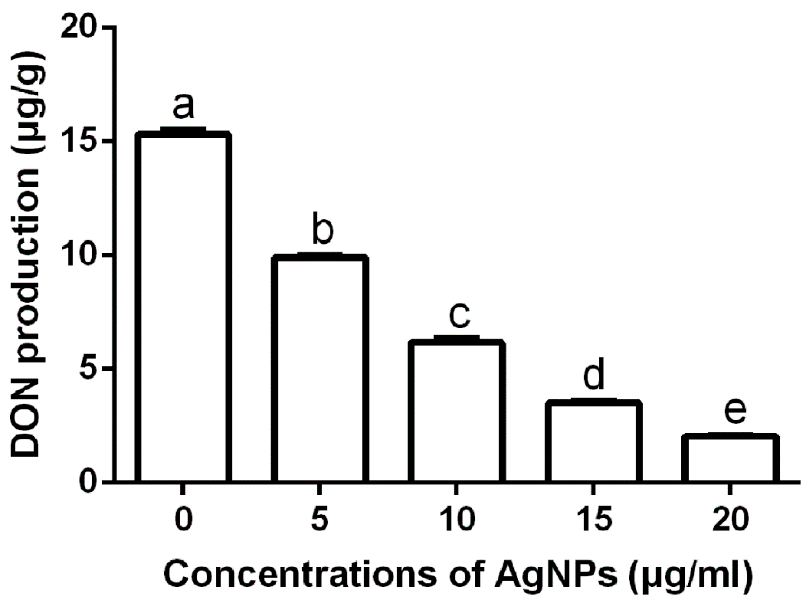
Figure 7. Effect of the synthesized AgNPs of different concentrations on deoxynivalenol (DON) production. The production of the DON of F. graminearum strain PH − 1 was inhibited by the biosynthesized AgNPs in vitro. Data are a mean value ± standard error of three replicates, and bars with the same letters are significantly different in LSD test ( p < 0.05).